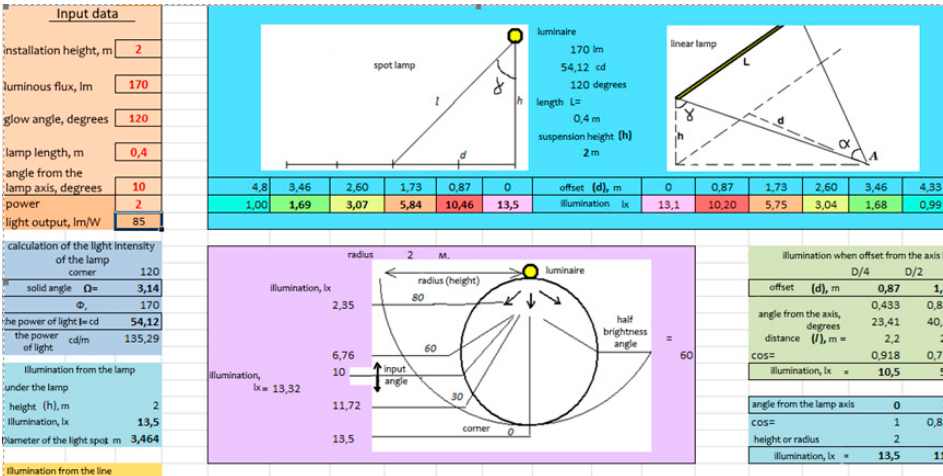
Figure 3. A fragment of the program developed by the authors for modeling illumination under a spot and linear lamp depending on the distance, angle of illumination and luminous flux of the light source.